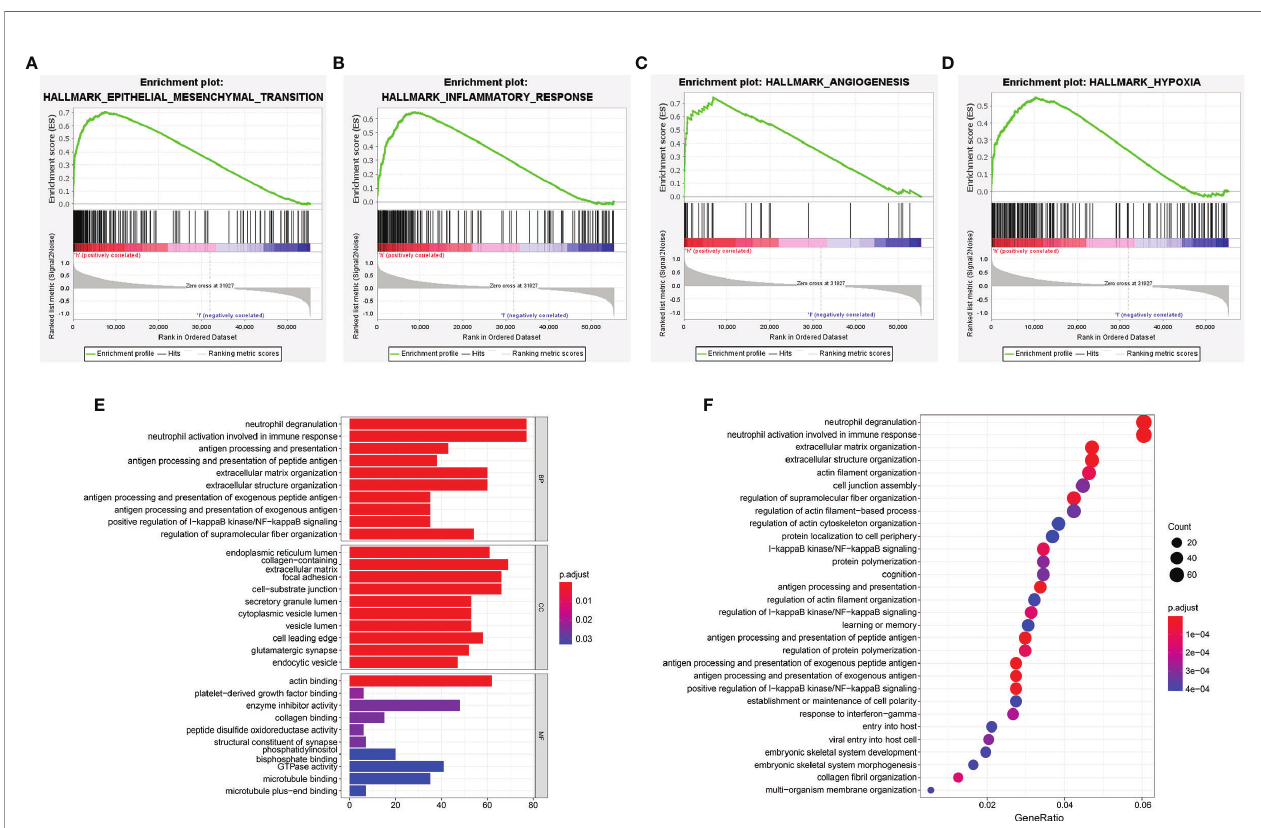
FIGURE 8 | Functional enrichment analyses of the risk signature. (A – D) GSEA analysis in TCGA cohort. (E, F) The GO enrichment (E) and KEGG (F) pathway